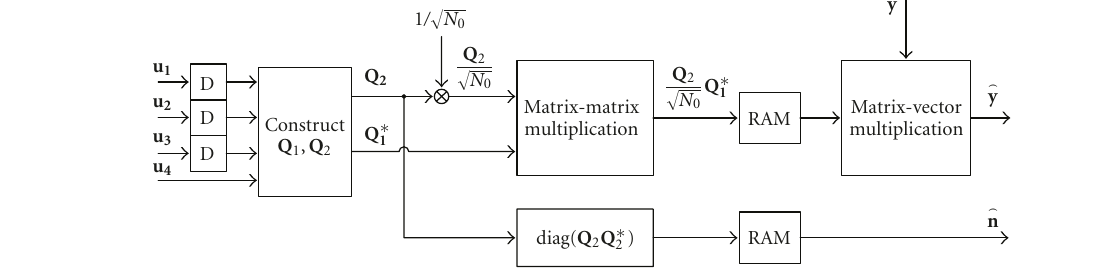
Figure 8: MMSE solution computation.